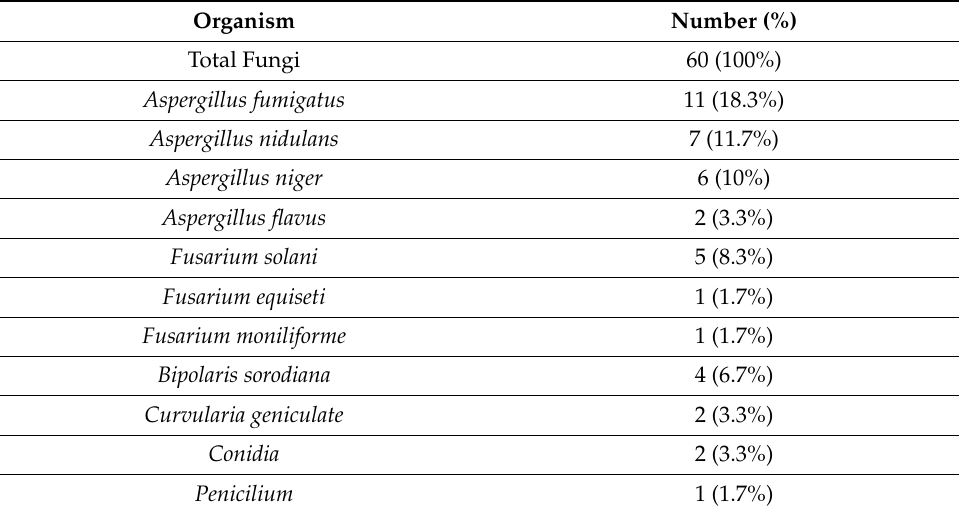
Table 1. Most common fungal etiologies in culture-positive post-traumatic endophthalmitis re- ported by Long et al. based on 912 reviewed cases [22].